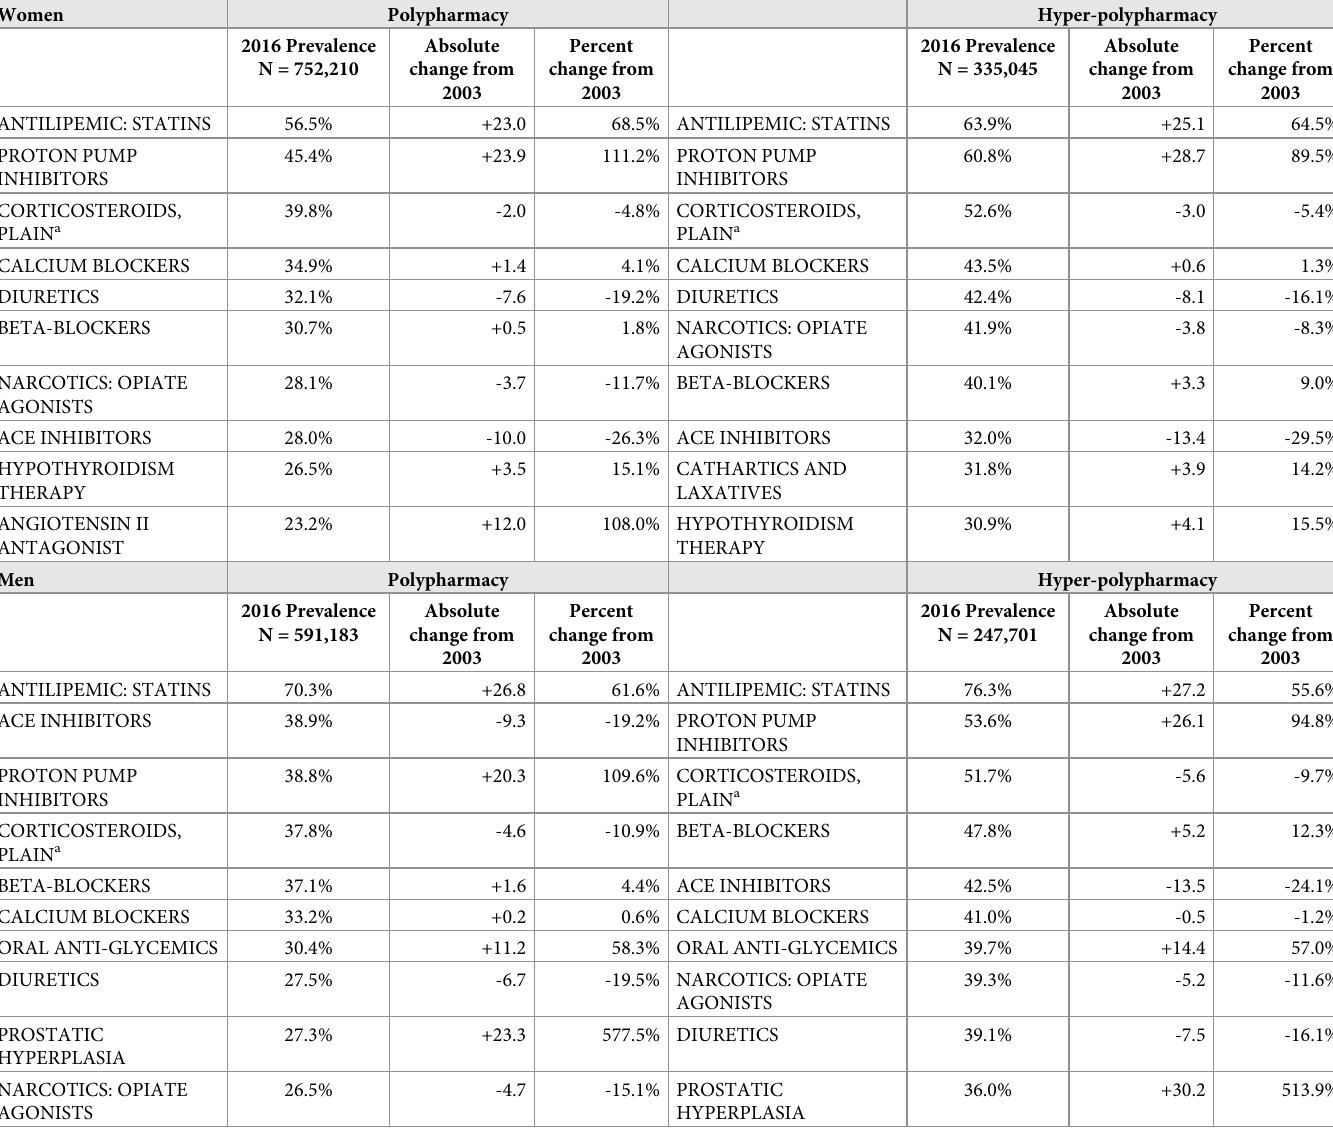
Table 4. Most frequently dispensed drug subclasses for women and men (age � 66 years) in Ontario, Canada in 2016 with polypharmacy and hyper-polypharmacy, and absolute/percent change from